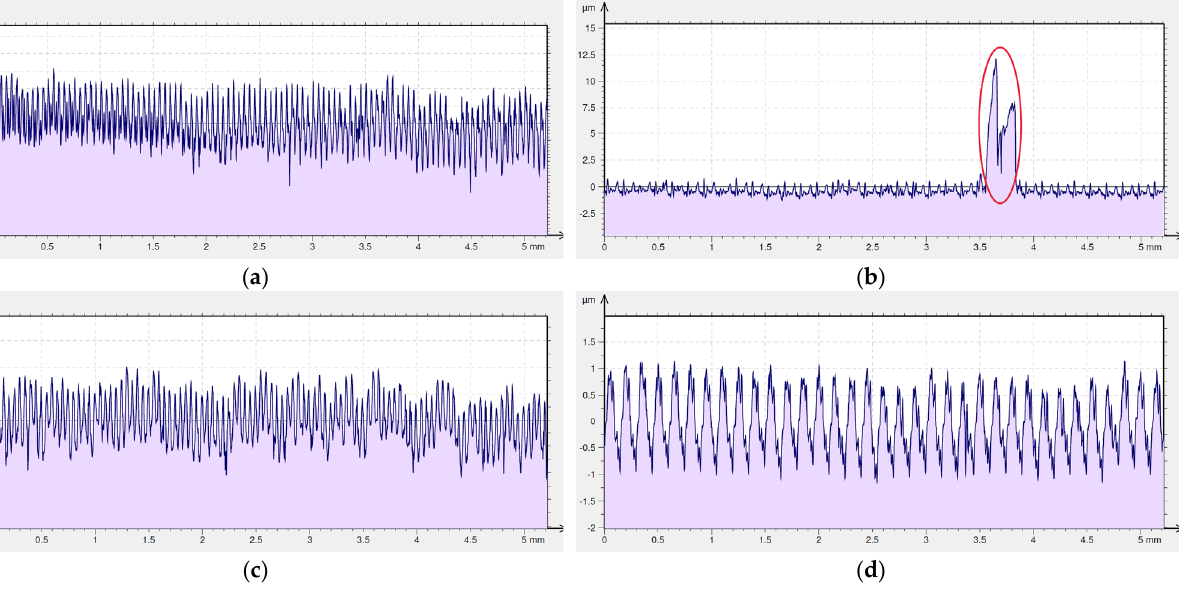
Figure 14. Surface roughness profile of Inconel 718 after turning by the Wiper insert (the sticking on machined surface is marked by red circle). ( a ) dry cutting, f = 0.05 mm/rev; ( b ) dry cutting, f = 0.15 mm/rev; ( c ) wet cutting, f = 0.05 mm/rev; ( d ) wet cutting, f = 0.15 mm/rev.